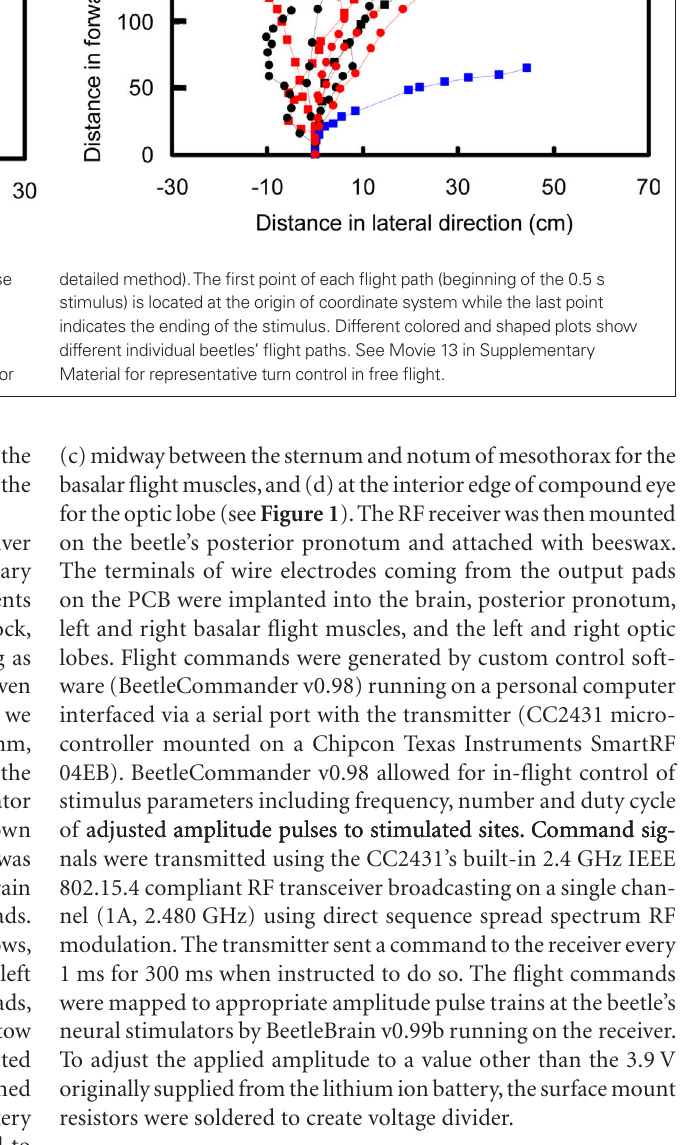
detailed method). The first point of each flight path (beginning of the 0.5 s stimulus) is located at the origin of coordinate system while the last point indicates the ending of the stimulus. Different colored and shaped plots show different individual beetles’ flight paths. See Movie 13 in